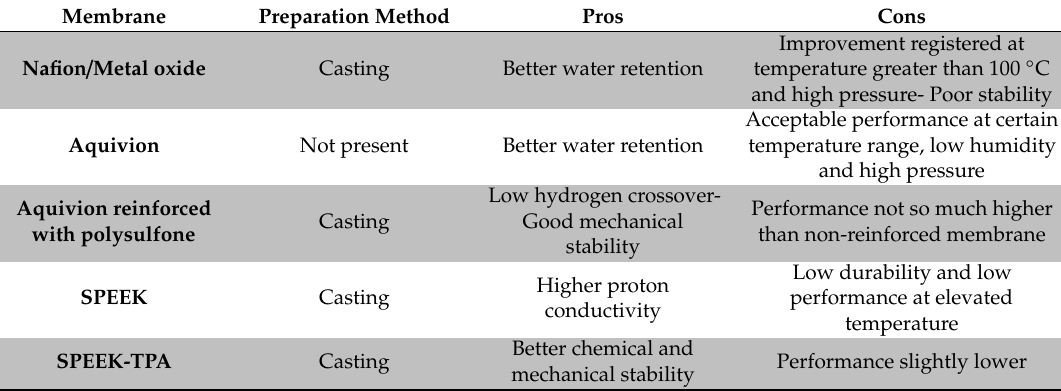
Table 4. Summary of electrolyser composite membrane properties.